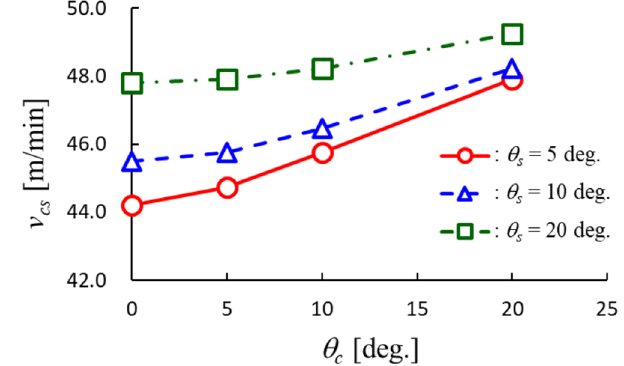
Fig. 14. In fl uence of u s and u c on v cs .